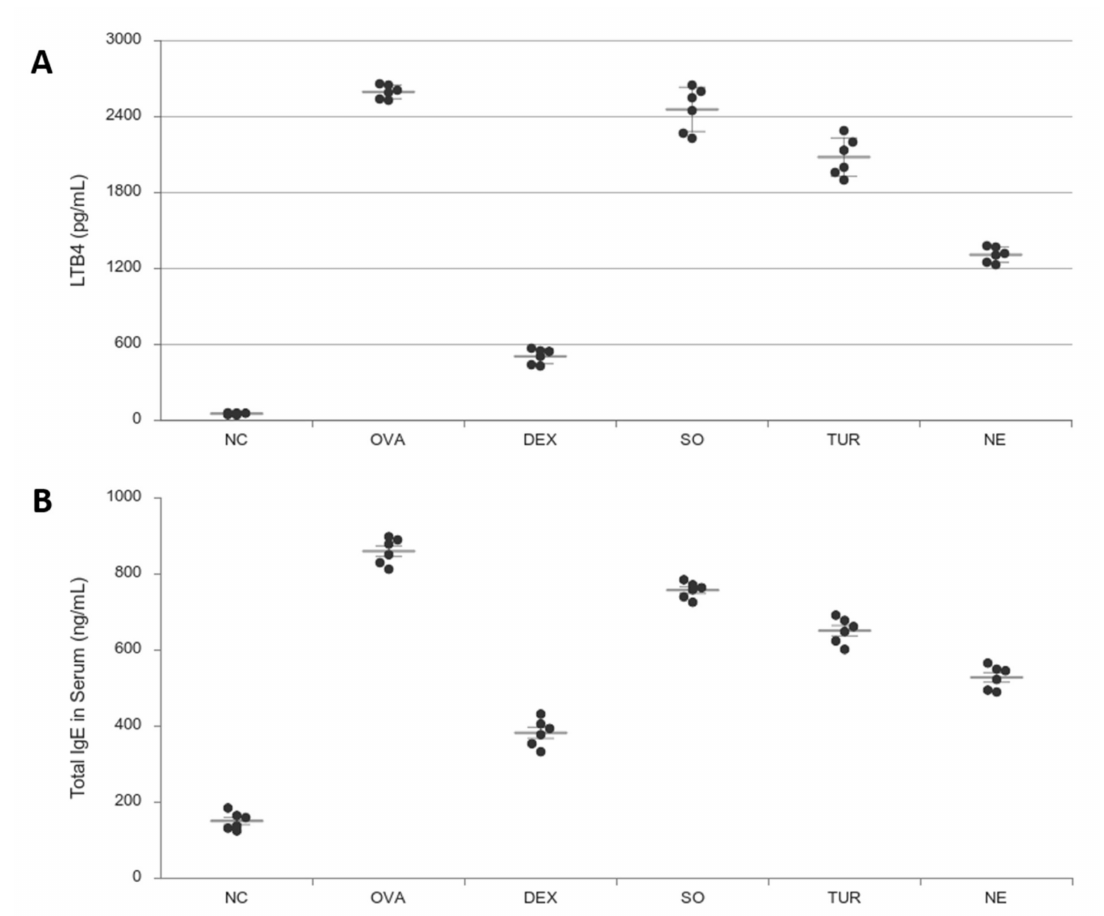
Figure 6. E ff ect of oral administration of dexamethasone (DEX), vehicle (SO), turmeric (TUR), and nano-emulsion on the levels of ( A ) LTB4 (pg / mL) and ( B ) IgE (ng / mL) in the plasma of OVA-sensitizedmice(i.p. 1stand10thday)andchallenged(inhalation, fromday19thto24th). Theresults were expressed as Mean ± SEM ( n = 6). One-way ANOVA was followed by the Student–Newman–Keuls test. DEX and NE has p < 0.001, TER has p < 0.01, SO has p < 0.05 compared with disease control (OVA), and OVA has p < 0.001 compared with